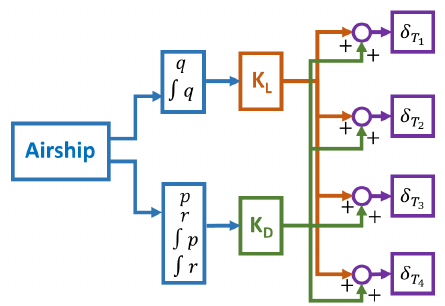
Figure 6. Stability augmentation logic for layout